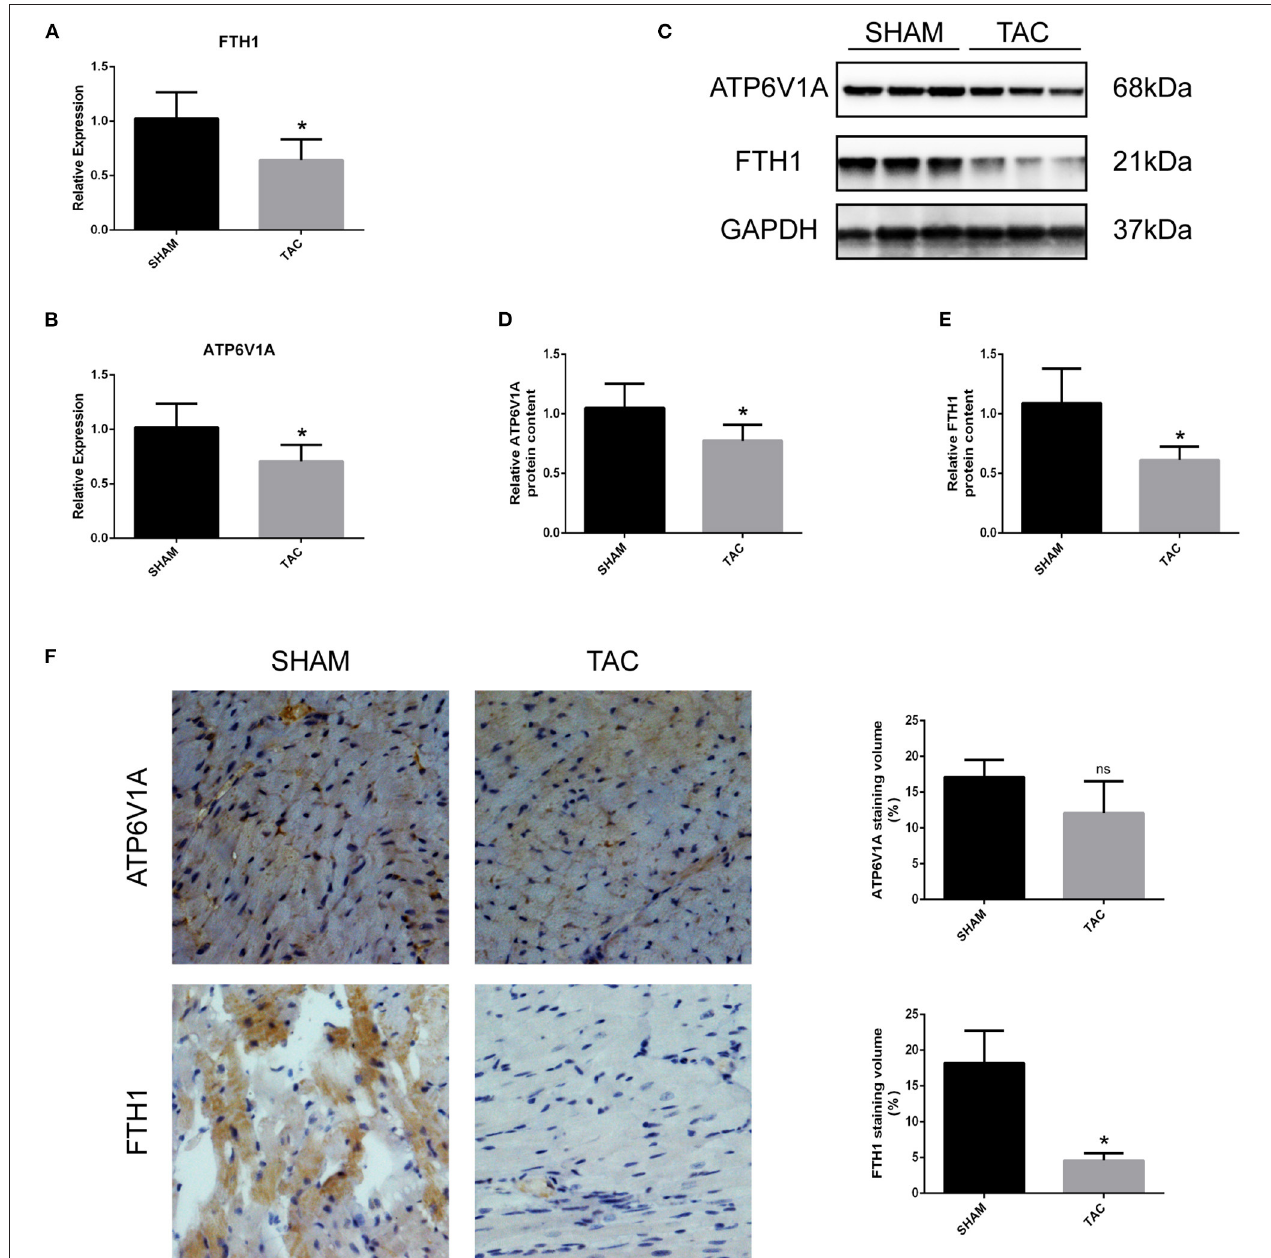
FIGURE 5 | QRT-PCR and Western blot analyses of ATH6V1A and FTH1 in myocardial tissues. (A,B) Representative qRT-PCR results of FTH1 and ATP6V1A in myocardial tissues. (C–F) Representative Western blot images, immunohistochemistry, and quantitative data of ATP6V1A and FTH1 in myocardial tissues. * P < 0.05; ns,